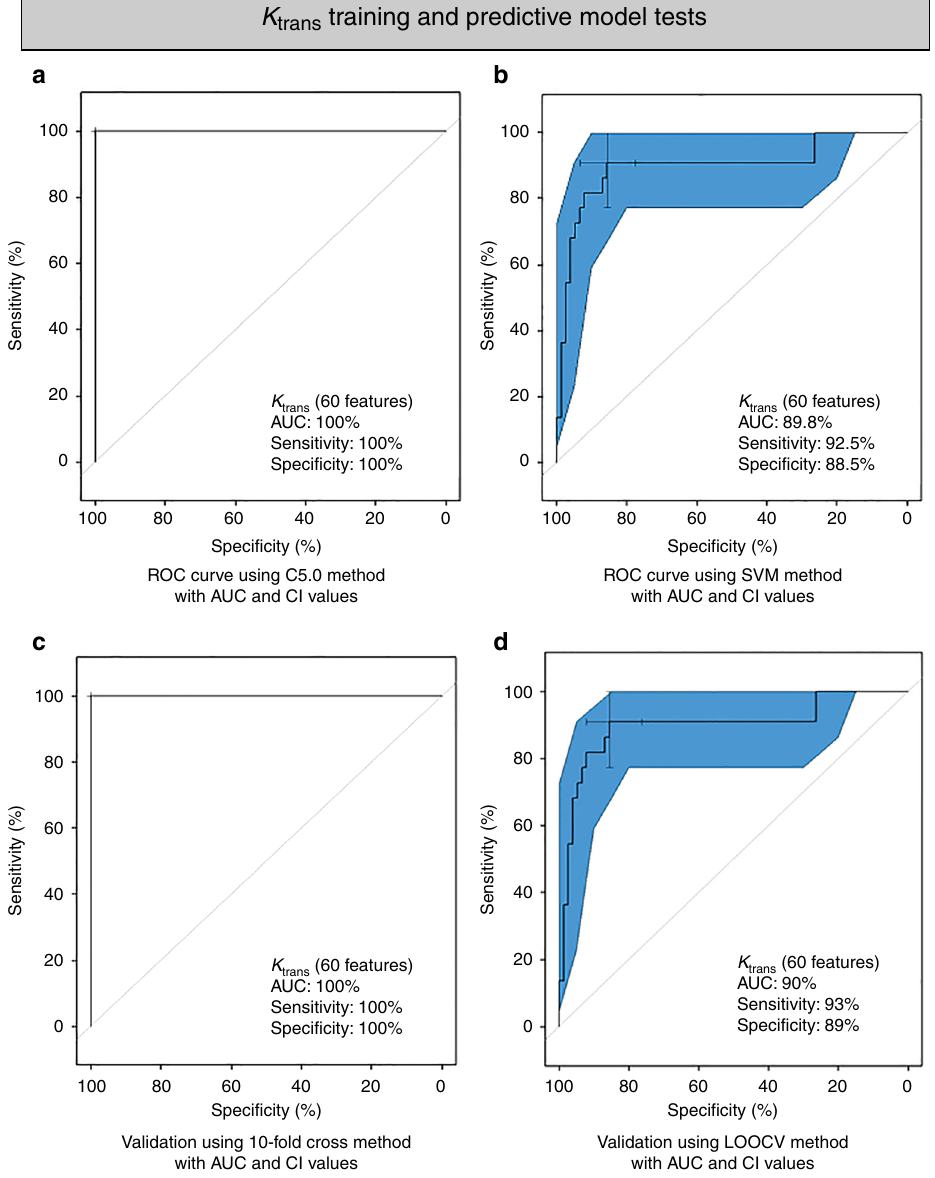
Fig. 2 Model building and evaluation using the selected K trans features (60 features). a , b ROC curve depicts the predictive model building using C5.0 ( P -value 1.512e − 11) and SVM methods ( P -value 0.003744) respectively. c , d 10-fold cross-validation ROC curve ( P -value 1.512e − 11) and Leave-One-Out Cross-Validation (LOOCV) ROC curve ( P -value 0.004) depicts the performance of the